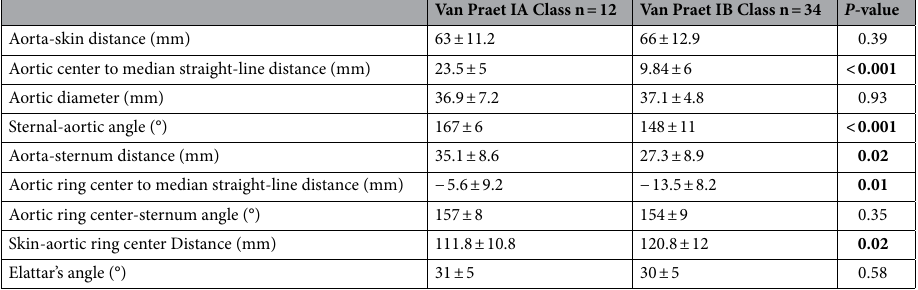
Table 1. Correlation between Van Praet class and CT scan measurements. Values in bold are those below the alpha risk threshold set at 0.05.